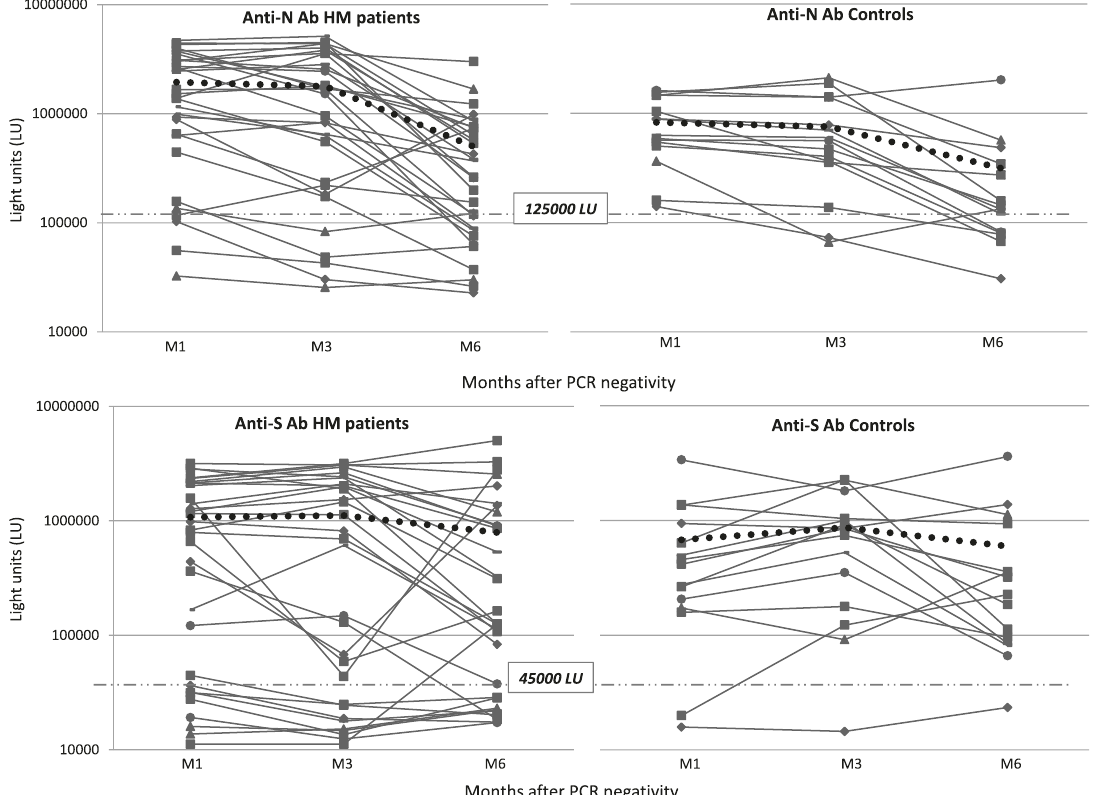
Fig. 1 Longitudinal pro fi le of antibodies against nucleocapsid and spike protein in patients with and without hematological malignancy. Nucleocapsid antibody (anti-N-Ab) levels and spike antibody (anti-S-Ab) levels were determined at 1 (M1), 3 (M3), and 6 (M6) months after nasal swabs became PCR-negative. The levels of Ab in light units against the nucleocapsid (top two panels) and spike protein (bottom two panels) over time were plotted on the y axis. The mean values of Ab levels are represented by the thick dotted lines. The cutoff values for determining seropositivity for anti-N-Ab and anti-S-Ab are shown by the thin dashed